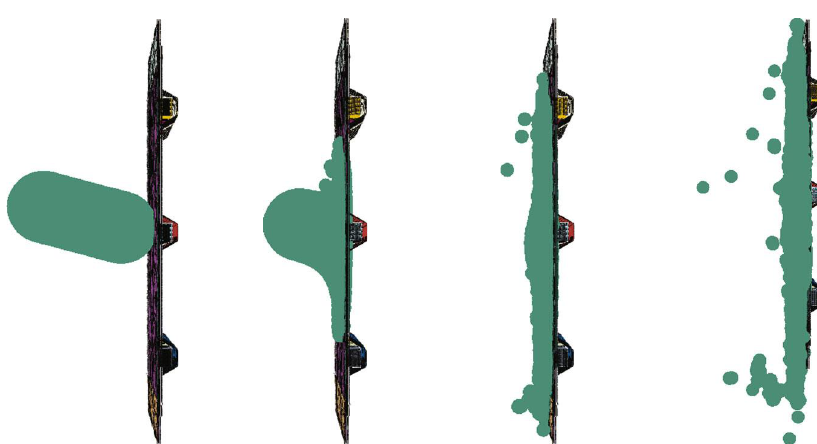
Figure 21: Morphology of the bird body at di ff erent moments of 75 °